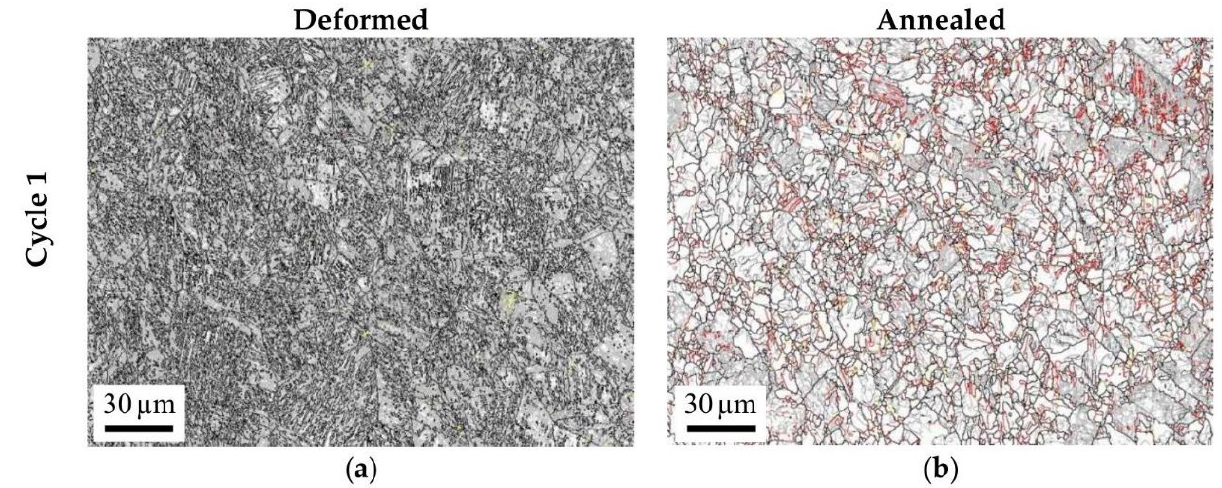
Figure 5. Grain boundaries construction maps for TMP samples processed using one cycle and strain of 0.30: ( a ) Deformed structure and ( b ) annealed structure.